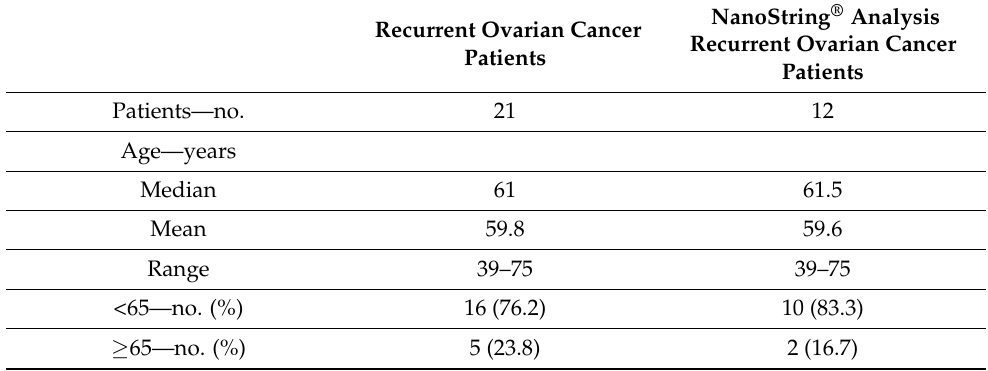
Table 1. Patient